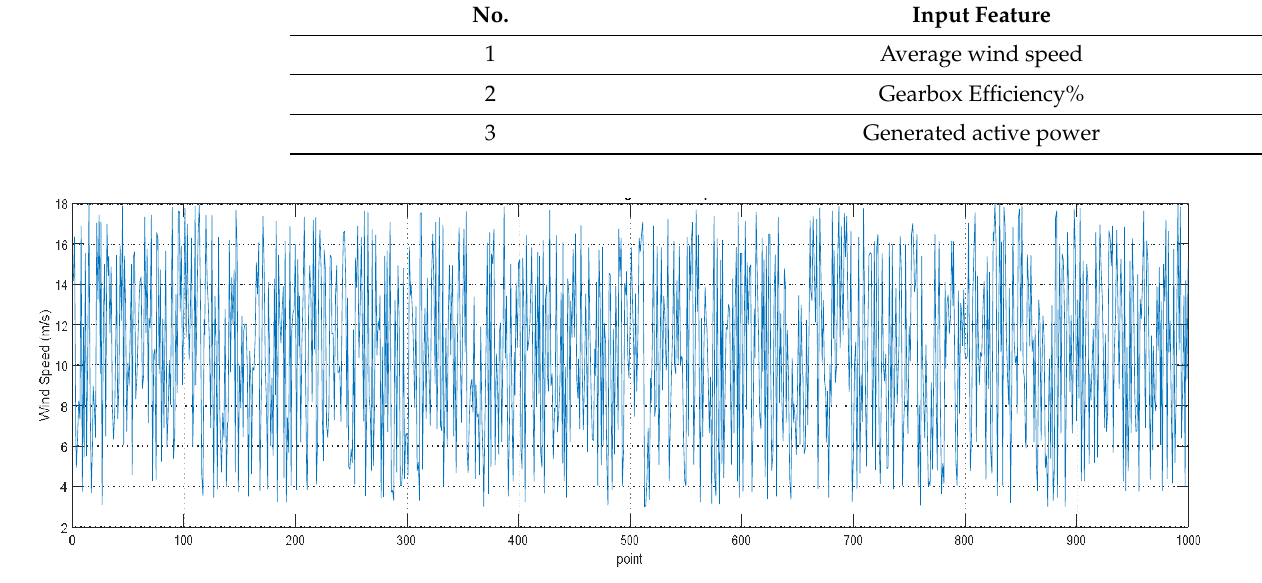
Figure 2. Ten minutes average sample simulated wind speed 2–18 m/s. Table 1. Selected input features of SCADA data.